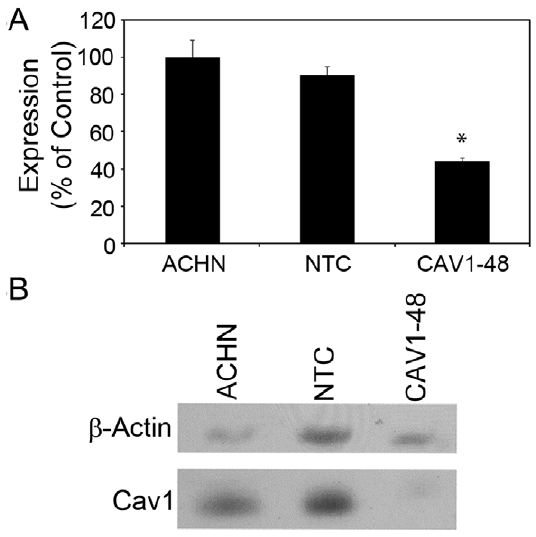
Figure 4. Caveolin 1 expression knockdown by shRNA. A) ACHN cells were stably transfected with a non-targeting control shRNA (NTC) or CAV1 (CAV1 – 48). Quantitative real-time PCR was used to determine the relative amount of CAV1 mRNA in transfected and non-transfected ACHN cells. Results of triplicate samples are shown and are expressed relative to non-transfected ACHN cells. The asterisk denotes CAV1 mRNA levels that are significantly different from non-transfected ACHN cells (p , 0.05, ANOVA followed by Dunnett’s post hoc test). B) Whole- cell lysates from non-transfected and stably transfected ACHN cells were immunoblotted with anti-CAV1 antibody; anti- b -actin antibodies were used as a loading control. A representative immunoblot is shown.